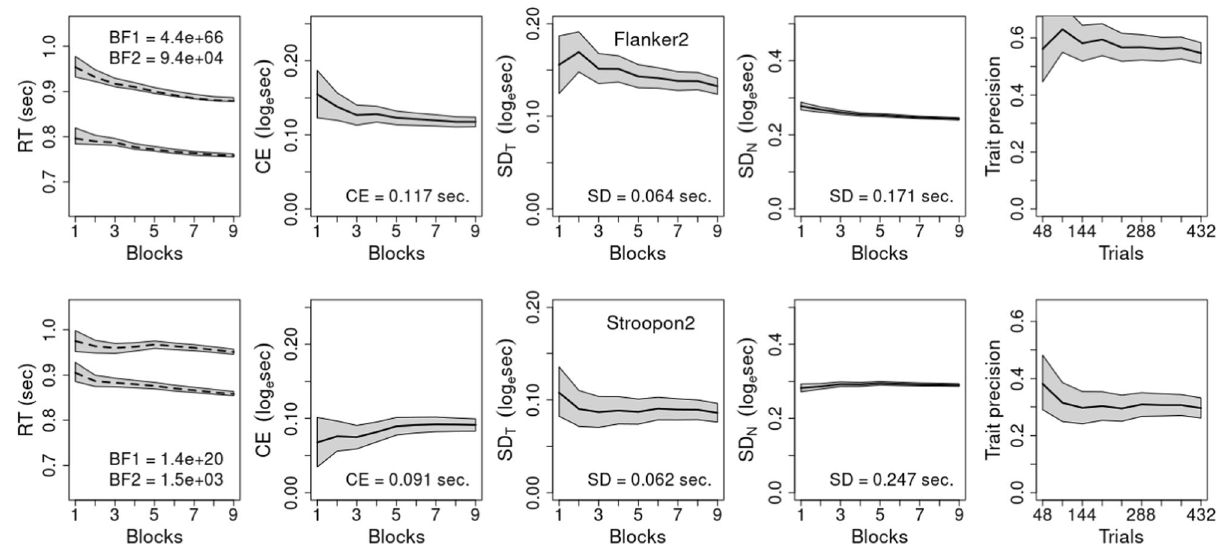
Fig. 8 | Results for non-gami fi ed experiment. The model assumes additive practice (blocks) and con fl ict fi xed effects, and random subject intercepts and con fl ictslopes. Blocks referto cumulative sets of 48trials and each row represents one task. In the fi rst column, dashed lines show mean response time (RT) for congruent and incongruent conditions calculated directly from data and Bayes Factors (BF) compare the assumed model in the numerator to models with (1) no